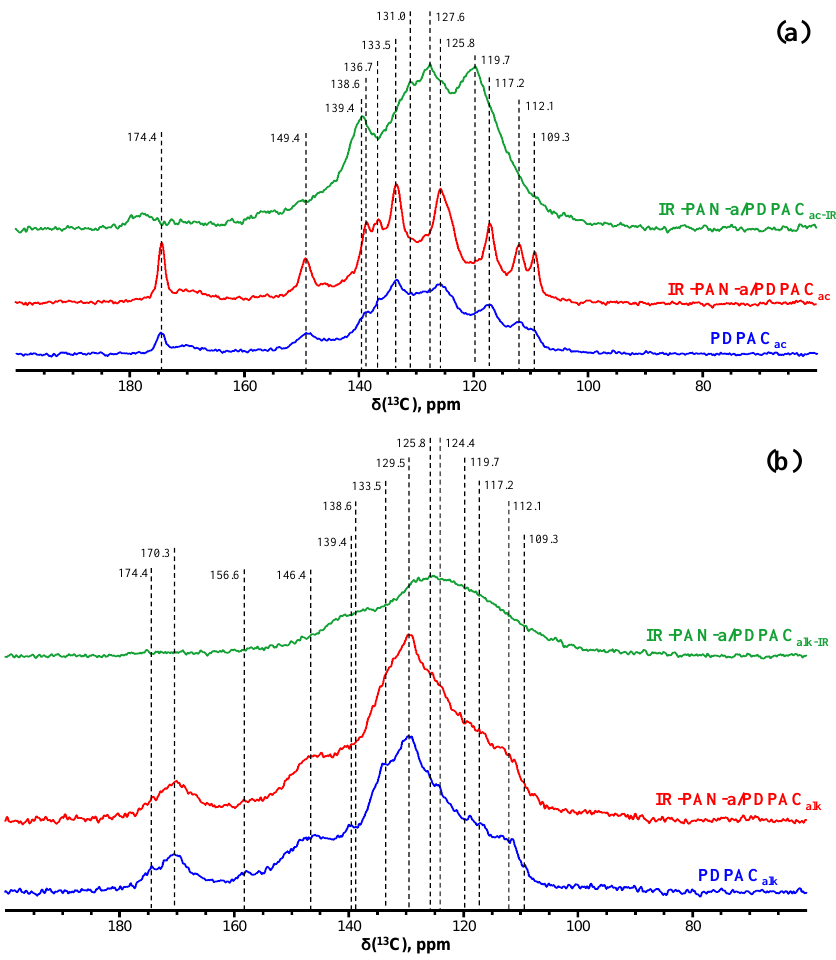
Figure 5. CP/MAS 13 C NMR spectra of PDPAC, IR-PAN-a/PDPAC, and IR-PAN-a/PDPAC IR prepared in an acidic ( a ) and an alkaline medium ( b ).